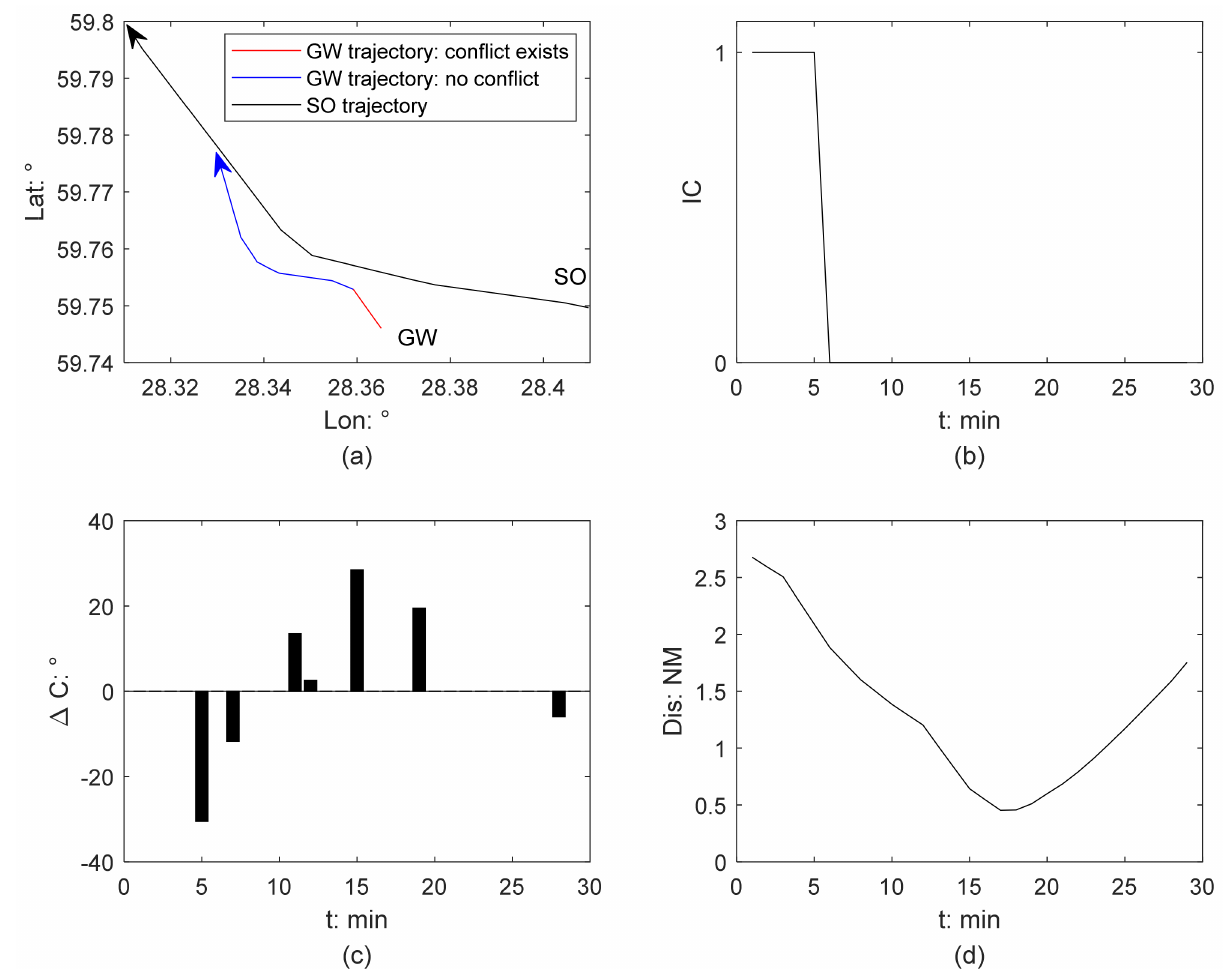
Figure 6. Ship collision detection from GW perspective in Scenario 2 ( a ) ship trajectory; ( b ) ship collision risk identification; ( c ) course change of a GW; ( d ) relative distance between this ship pair.